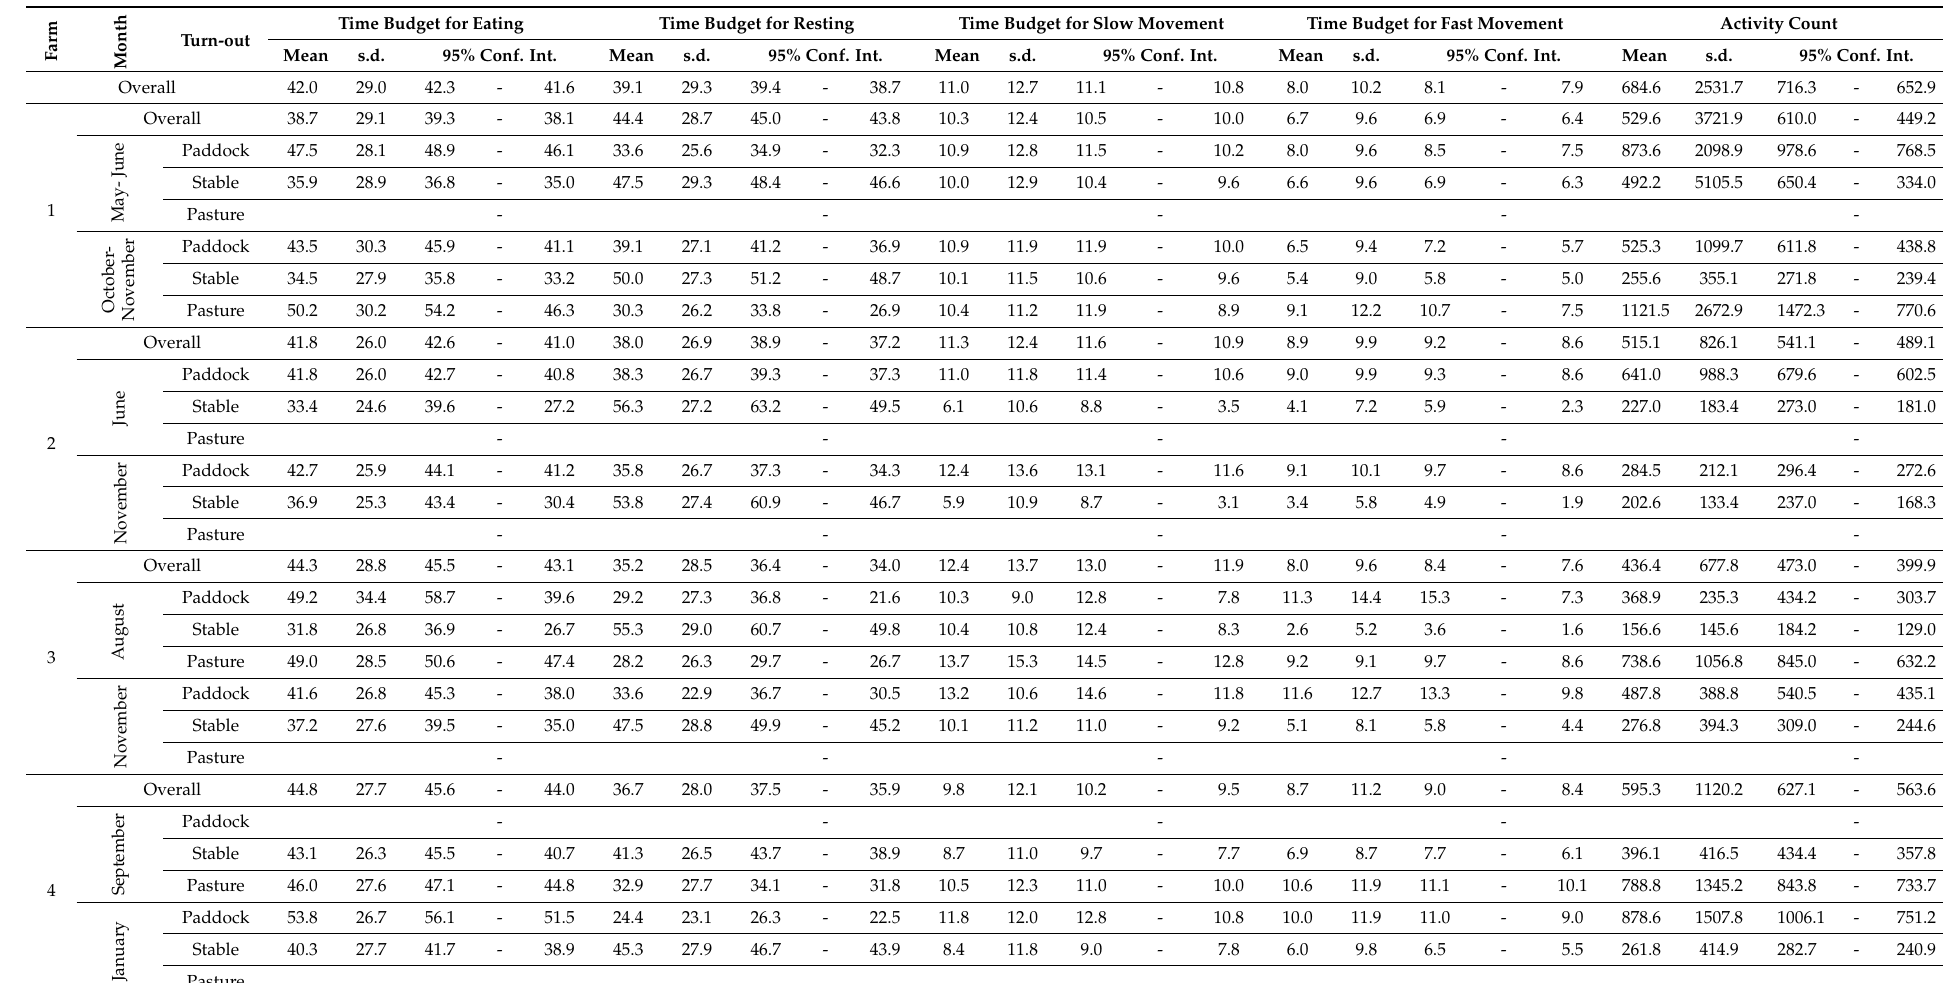
Table 1. Time budget for eating, resting, slow movement (“active”), fast movement (“highly active”) and the activity counts by farm, season and turn-out